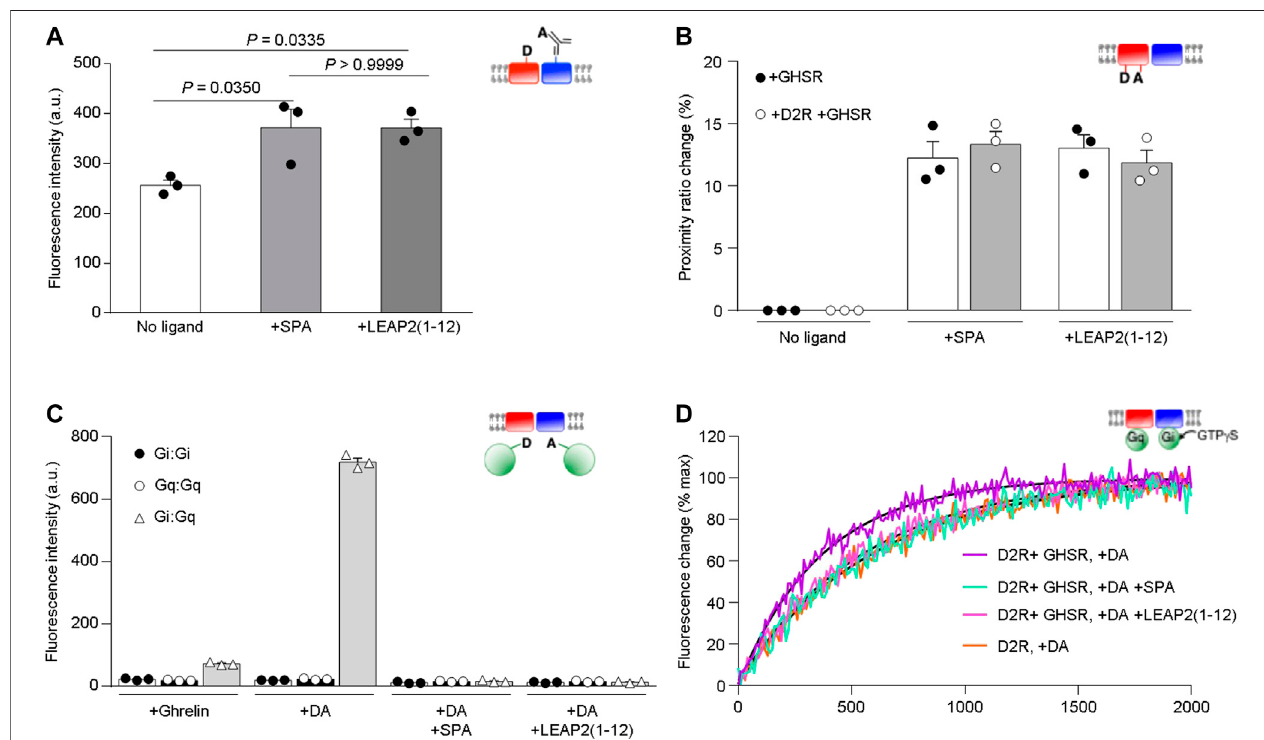
FIGURE 4 | Impact of LEAP2 on GHSR structure and dopamine-mediated Gi activation. (A) XL255 emission intensity after Tb-cryptate excitation of proteoliposomes containing Tb-cryptate labeled GHSR and XL255-labeled D2R in absence of ligand (No ligand) or in presence of 10 µM SPA (+SPA) or LEAP2 (1 – 12) [+LEAP2 (1 – 12)]. Statistical signi fi cance was evaluated by One Way ANOVA and Tukey ’ s post-test. (B) Proximity ratio changes induced by 10 µM of SPA (+SPA) or LEAP2 (1 – 12) [+LEAP2 (1 – 12)] calculated from the FRET signal between the fl uorophores in TM1 and TM6 of GHSR assembled into lipid nanodiscs either as a homomer(+GHSR)oraheteromer(+GHSR+D2R). (C) AF-488emissionintensityafterAF-350excitation.G α iandG α qwerelabeledattheirNterminuswithAF-350and AF-488, respectively, and fl uorescence was measured in the presence of the labeled G proteins, the GHSR-D2R heteromer in lipid nanodiscs and 10 µM ghrelin (+Ghrelin), 10 µM dopamine (+DA), or 10 µM dopamine in the absence or in the presence of either 10 µM SPA (+DA +SPA) or LEAP2 (1 – 12) [+DA +LEAP2 (1 – 12)]. (D) GTP γ S binding to G α i1 in G α i1 β 1 γ 2 catalyzed by the GHSR-D2R heteromer in the presence of 10 µM dopamine (DA) and in absence or in the presence of either 10 µM SPA or LEAP2 (1 – 12). GTP γ S binding to G α i1 catalyzed under the same conditions by the D2R homomer in the presence of 10 µM dopamine (DA) is given for comparison. The species considered are schematically depicted in all cases (red: GHSR, blue:D2R, green: G protein). Data in ( A – C ) is mean ± SD of three